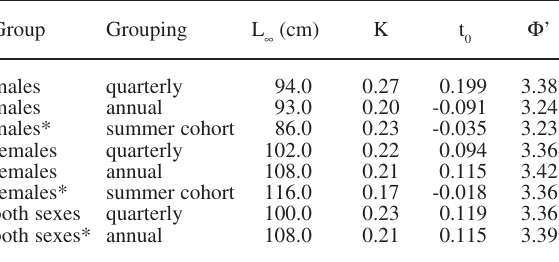
relationships found for both morphometrics and relative growth. Relationships between longitudi- nal otolith axes, and with fish length, were isomet- ric. The weight increase of the otolith (g), both GROWTH OF MERLUCCIUS MERLUCCIUS 149